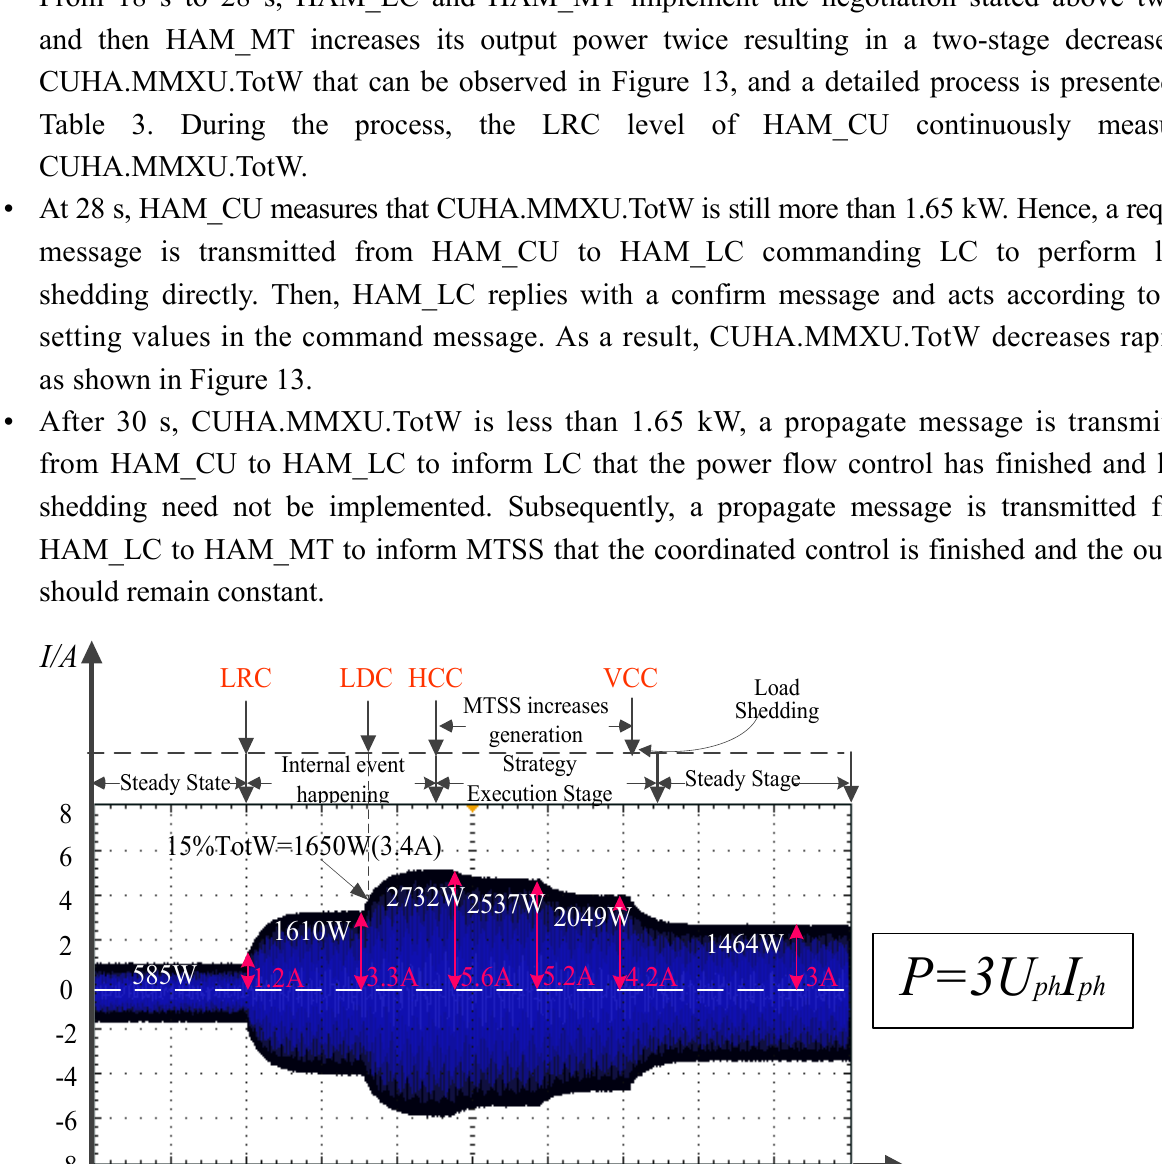
3. During the process, the LRC level of HAM_CU continuously measures